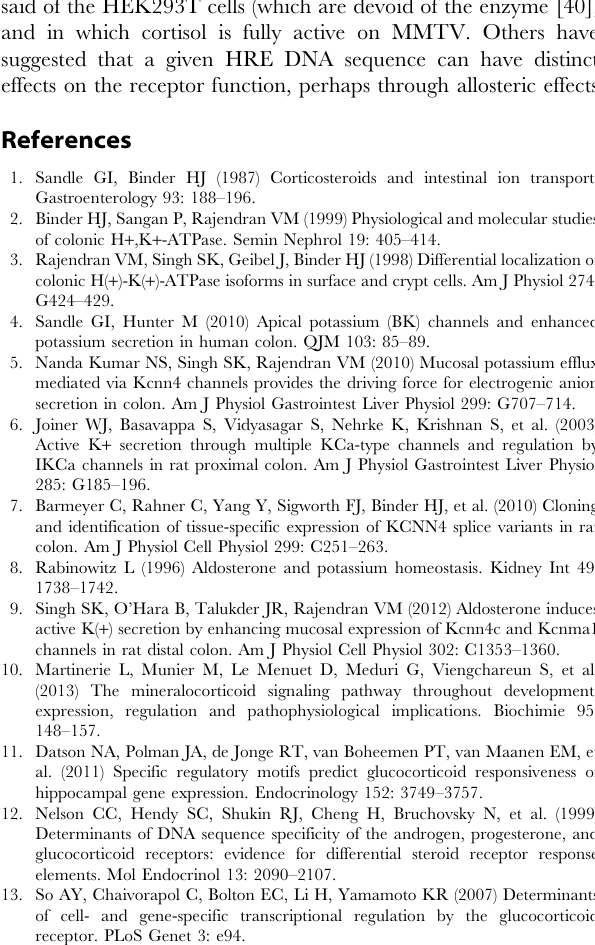
Figure S1 Sequence of Clones 1, 5, and 6 and of selected sub-clones. Clones 5 and 6 overlap by 138 bp, all contiguous sub-clone inserts overlap by approximately 50 bp, and 5Ba and 5Bb overlap by 21 bp. Potential HREs are underlined. Exon 2 (99 bp) in 5B is underlined. Table S1 Primer sets used in ChIP. Primer sets are numbered with reference to the genomic DNA block they are directed to amplify. For example, Primer set 1 (forward and reverse primers) RT-PCR amplify approximately 100 bp in DNA block 1, approximately 20 kb upstream of the presumed Kcnn4 transcription start site (TSS). Table S2 Primer sets used for cloning candidate enhancer regions from genomic